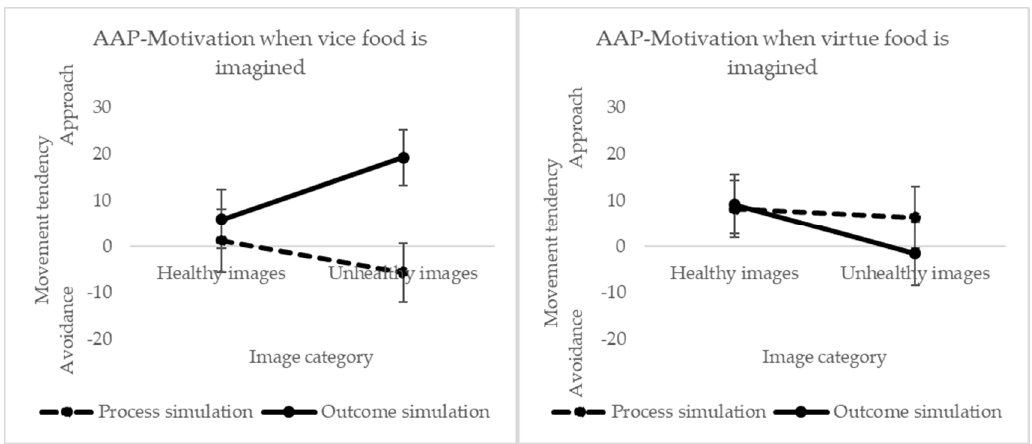
Figure 3. Approach-avoidance tendencies by type of mental simulation and product imagined.